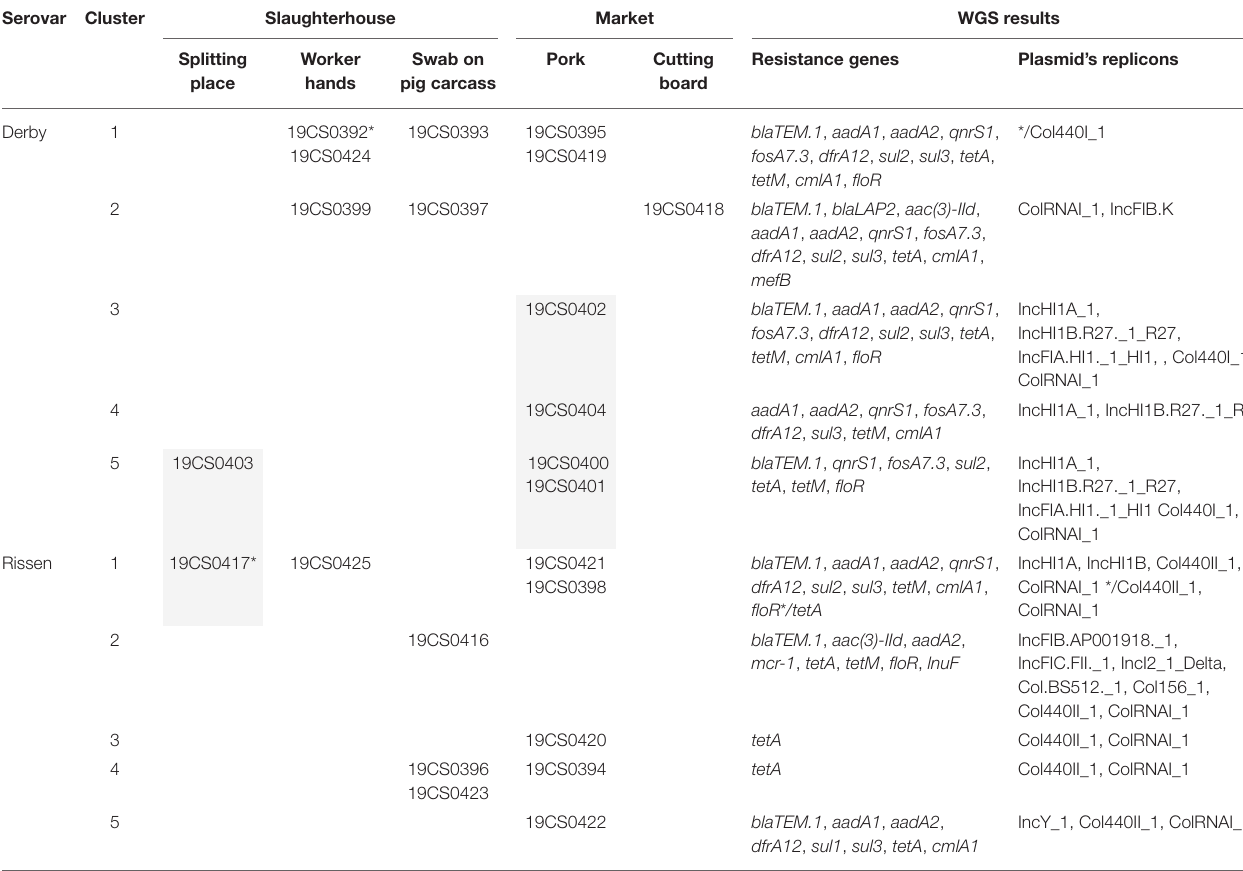
TABLE 5 | Isolates organized in clusters with information about the collection place, resistance genes, and plasmid replicons. Serovar Cluster Slaughterhouse Market WGS results Splitting Worker Swab on Pork Cutting Resistance genes Plasmid’s place hands pig carcass board